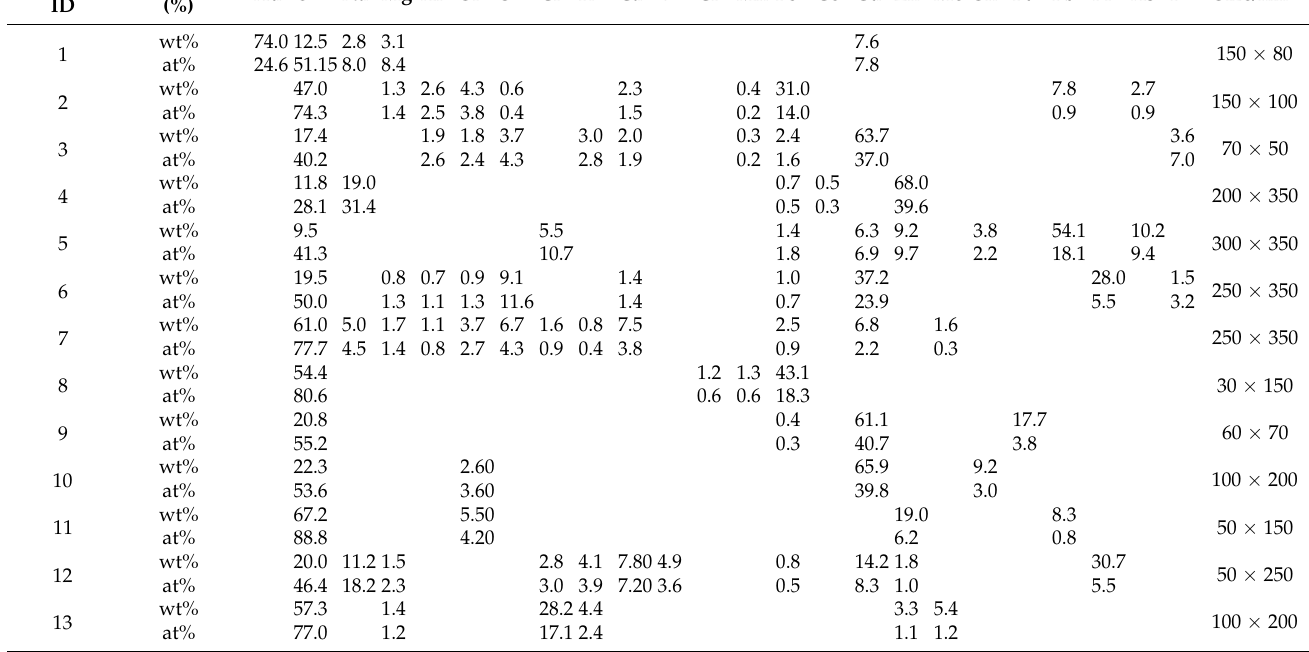
Table 2. The EDS data of particles and particle aggregations in deep-seated fault gouge (ID1-7) and ascending gas flow